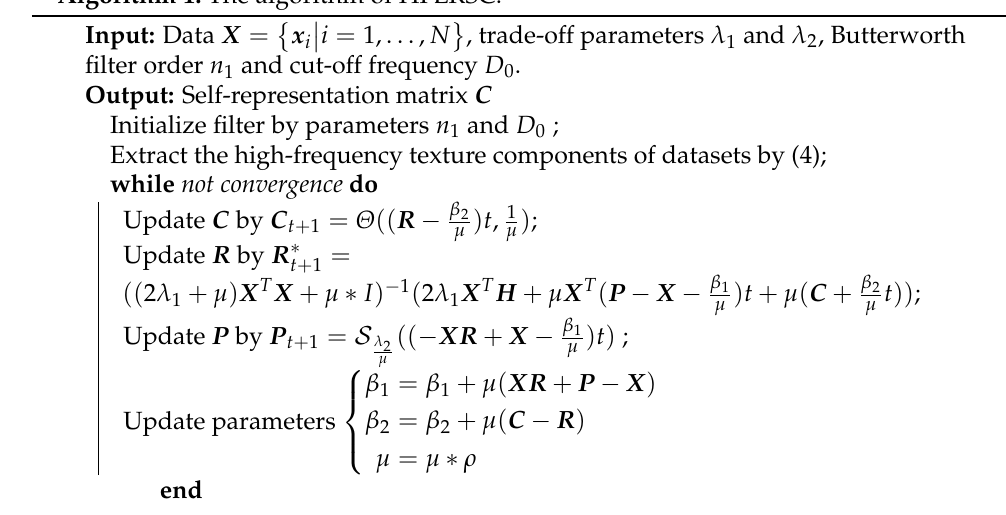
Algorithm 1: The algorithm of